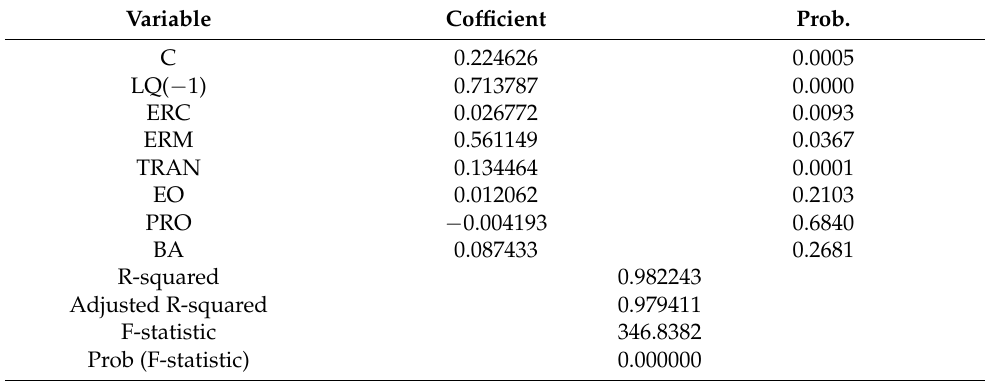
Table 8. Regression results of the effect of environmental regulation on industrial